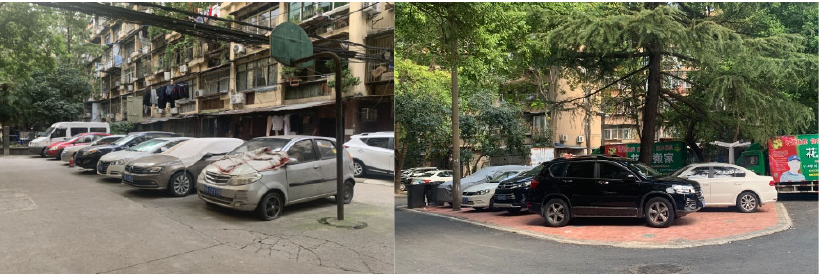
Figure 9. Parking lots occupy public spaces in Libei and Huaqiao neighbourhoods.